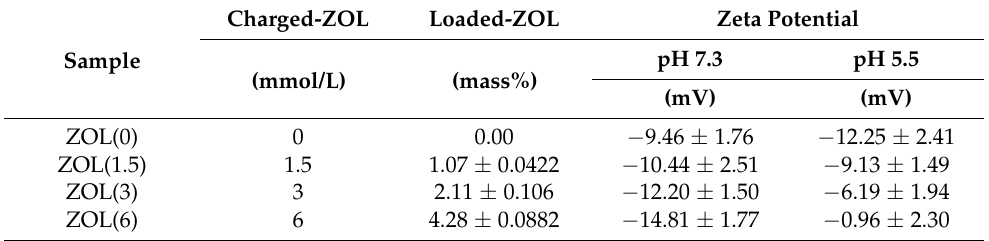
Table 1. Characterization of zoledronic acid (ZOL)/ β -tricalcium phosphate ( β -TCP) powders.